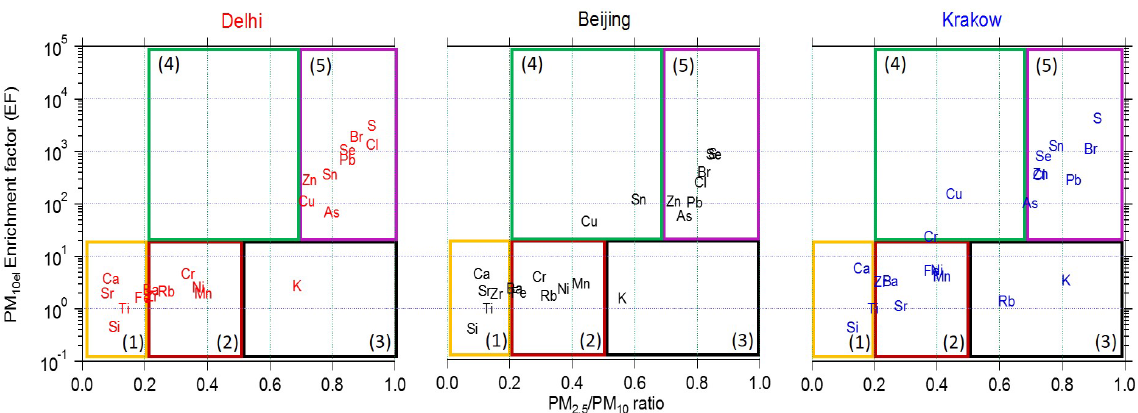
Figure 2. Classification of the measured elements in five groups for Delhi, Beijing, and Krakow based on their PM 10 enrichment factor (EF) vs. PM 2 . 5 / PM 10 values. PM 10 EF vs. PM 2 . 5 / PM 10 values and PM 2 . 5 EF vs. PM 2 . 5 / PM 10 values for all four sites are shown in the Supplement (Fig.